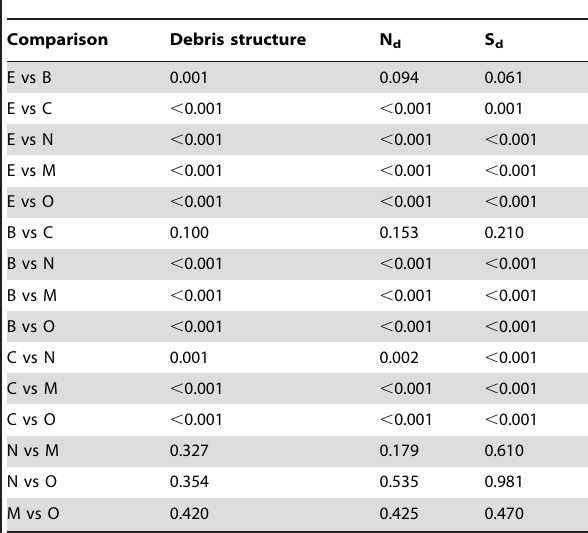
Table 1. Summary of pairwise contrasts (PERMANOVA) amongst habitats for the multivariate tests of differences in debris structure, and for the univariate tests for abundance (N d ) and diversity (S d ). P(perm) values are shown with significant terms in bold font. E = estuary; B= bay; C= coastal; N= nearshore reef; M= mid-shelf reef; O= offshore reef.